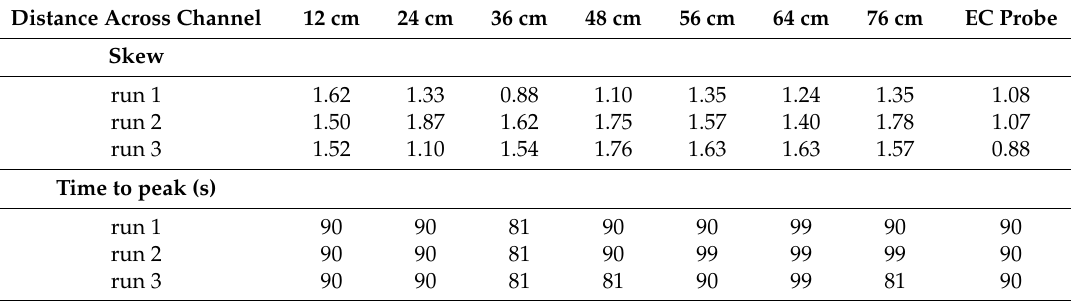
Table 5. Koulbich. Tracer results for skewness and time to peak.